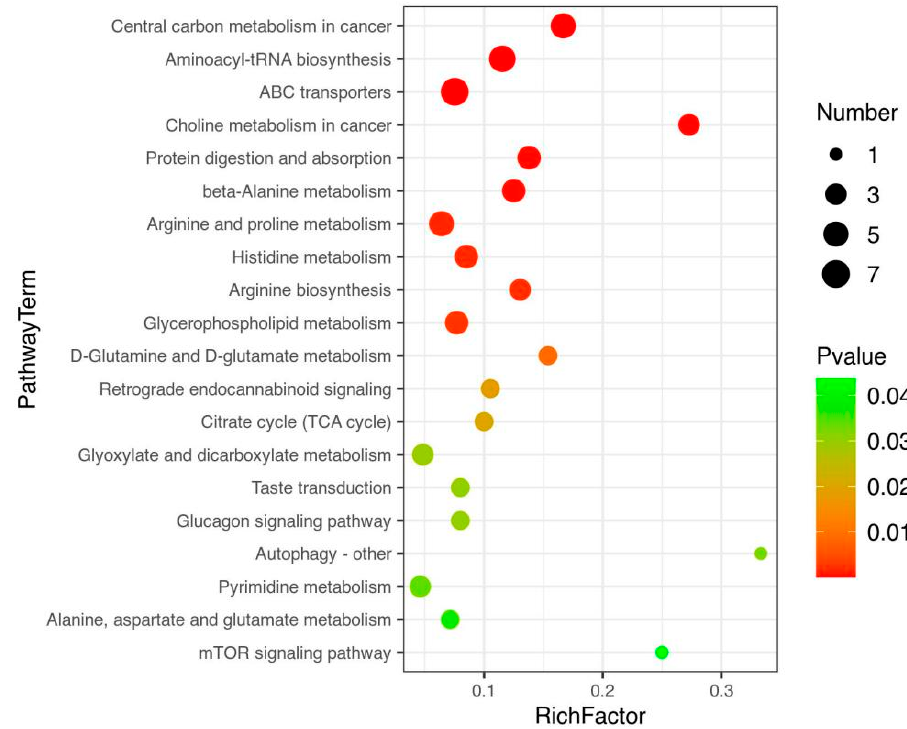
Figure 7. Bubble chart (using adj-P analysis).